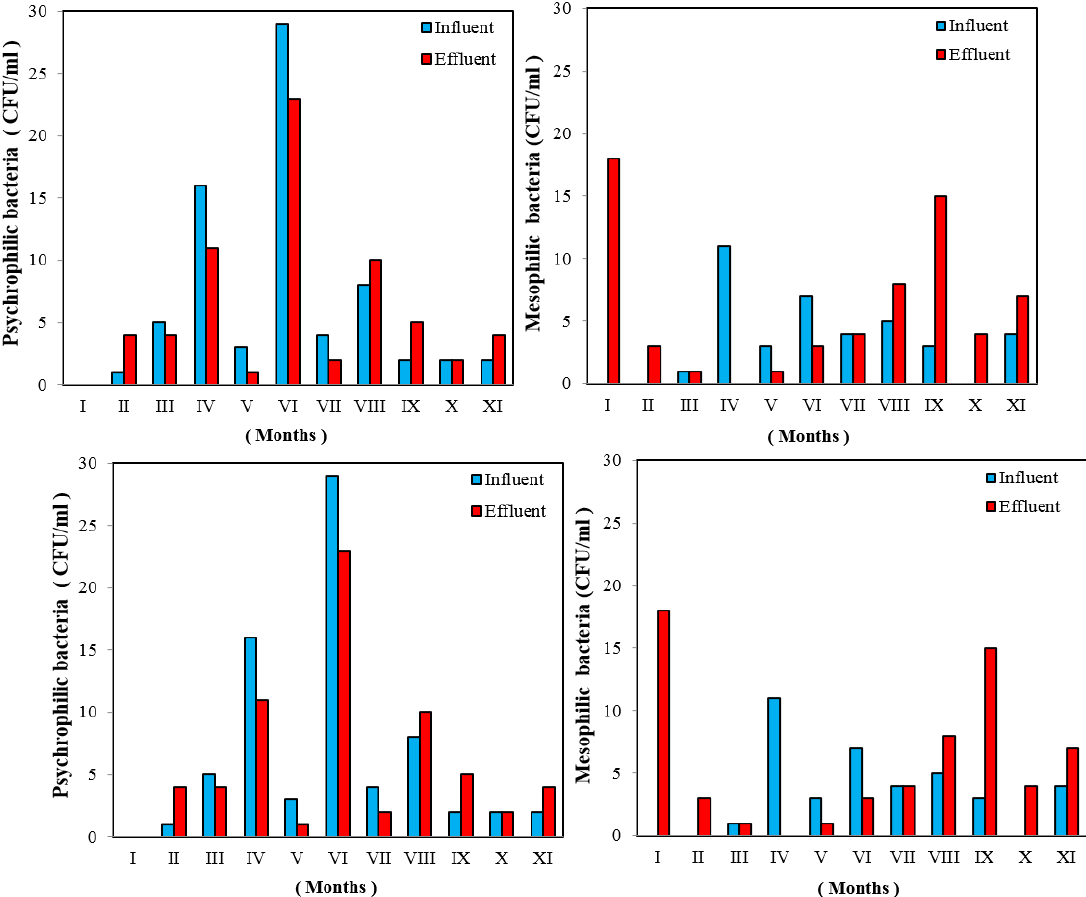
Figure 7. Total number of mesophilic and psychrophilic bacteria in water before and after the biofiltration process.